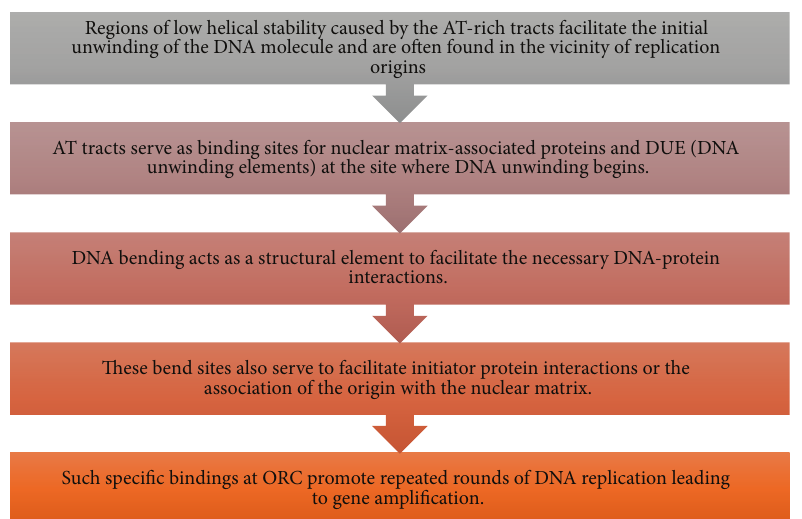
Figure 12: Mechanism of gene amplification based on combined analysis of thermodynamic factors. The steps involved in the origin and progression of gene amplification in S. cerevisiae